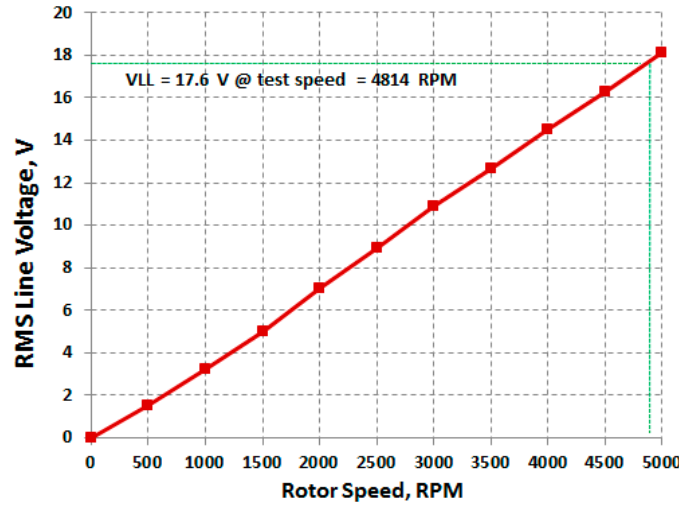
Figure 8. Expected AFPMA line–line rms voltages at no load for several operating speeds.